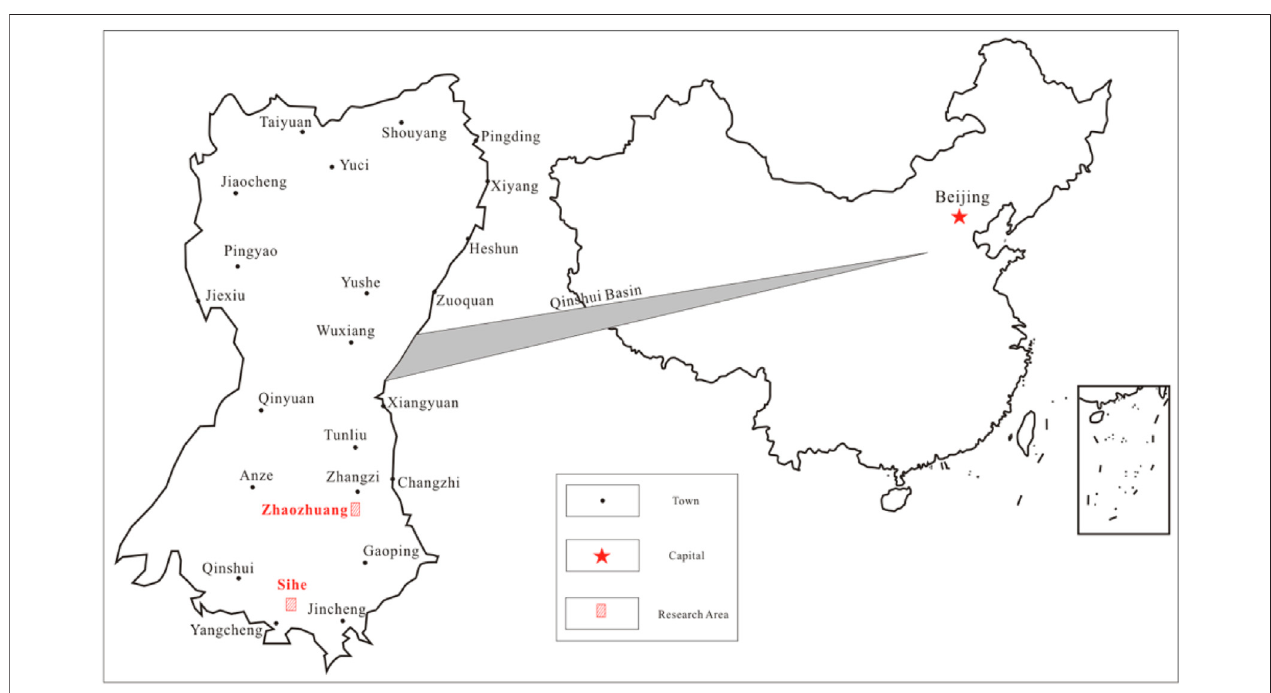
FIGURE 1 | Location of the research area in Qinshui Basin, China.